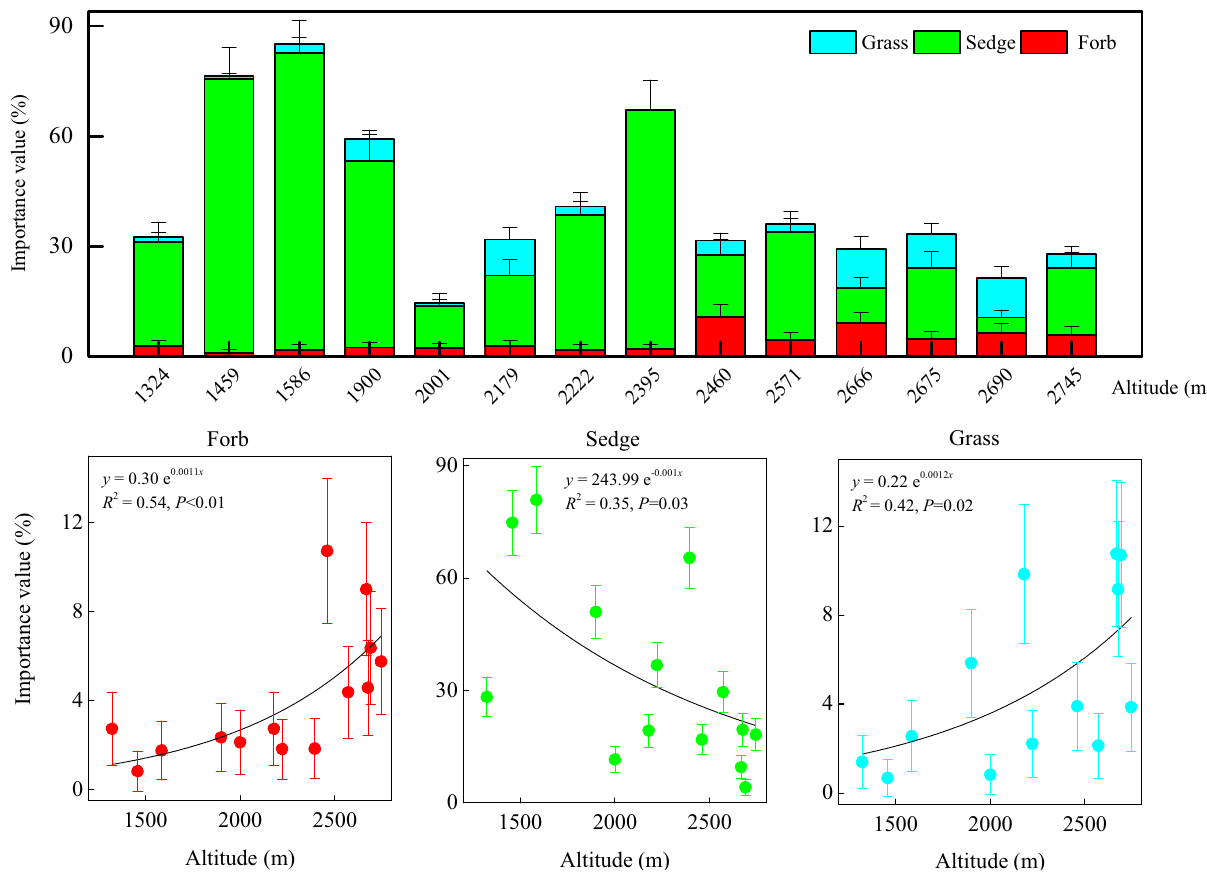
Figure 3. Distribution and variation of the importance values of grasses, sedges, and forbs at different elevations. The grass, sedge, and forb species belonged to Gramineae, Cyperaceae, and other families, respectively. At each elevation, species of the herb community were divided into these three life forms. Their importance values were used in regression analyses with the altitudinal gradient. Data for the importance values of grasses, sedges, and forbs were averaged from 80 sub-quadrats at each elevation.